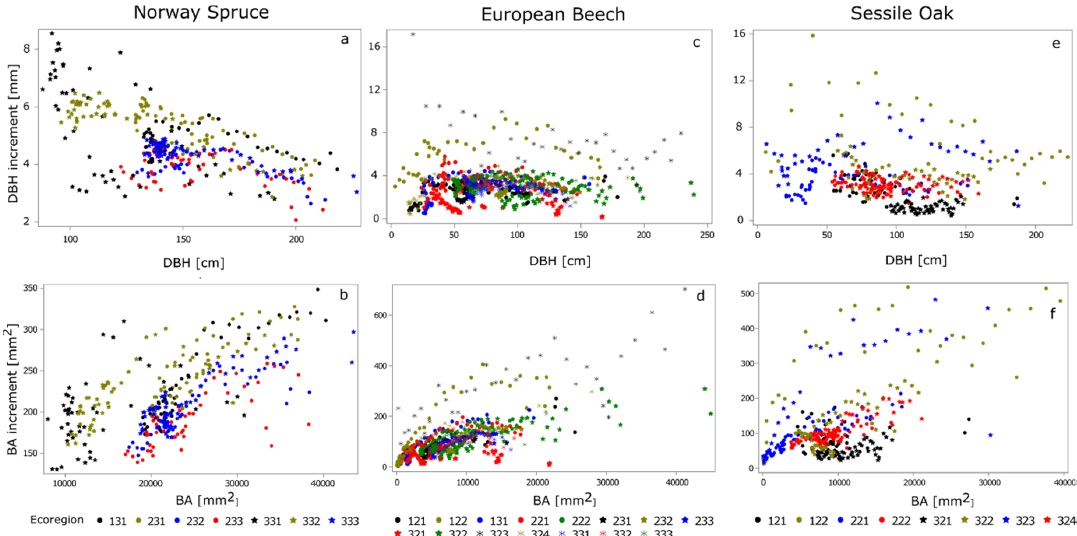
Figure 4. Mean DBH increment versus mean DBH and mean basal area increment versus mean basal area by ecoregion for Norway spruce ( a , b ), European beech ( c , d ) and Sessile oak ( e , f ). Irrespective of the species, the AIC identified the first order autoregressive structure as the most suitable covariance structure. For Norway spruce, the ecoregions were found to have a significant